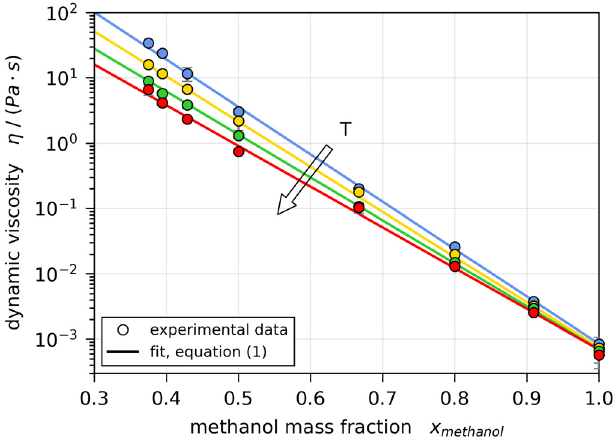
Figure 2. Concentration- and temperature-dependent dynamic viscosity η of poly(vinyl acetate)- methanol solutions for 𝑇 = 10 , 20 , 30, and 40 °C .